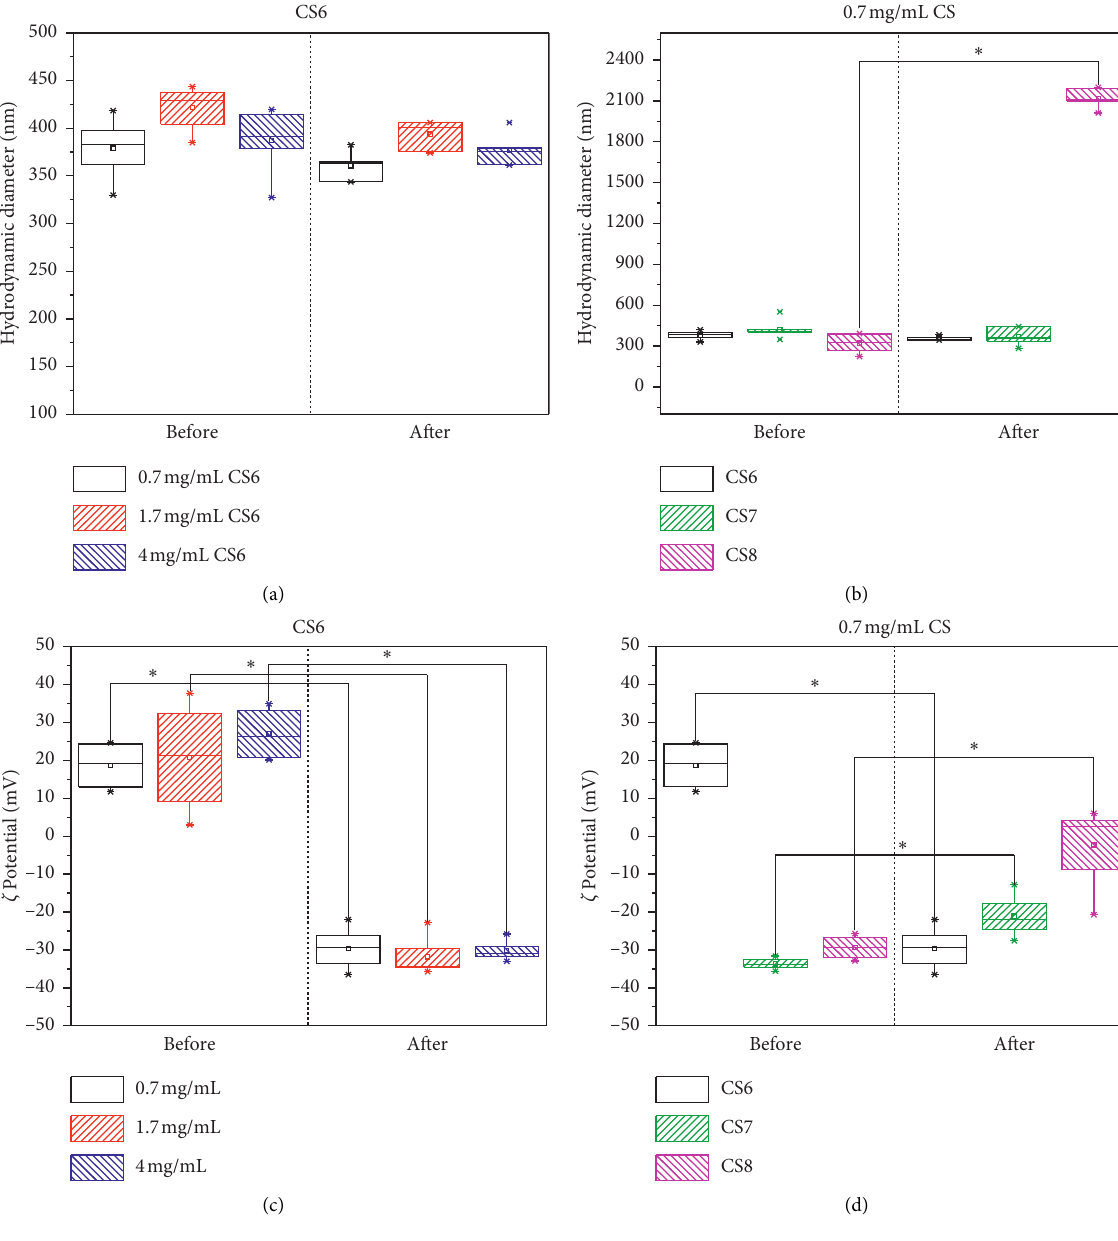
Figure 2: Dynamic Light Scattering (DLS) and ζ -potential results for CS materials. Hydrodynamic particle size ( n � 4 synthesis replicates) and ζ -potentials before and after exposure to the fibrin precursor. (a), (c) CS6 at different concentrations and (b), (d) CS6, CS7, and CS8 materials. ∗ Different at a significance level of 0.005. n �